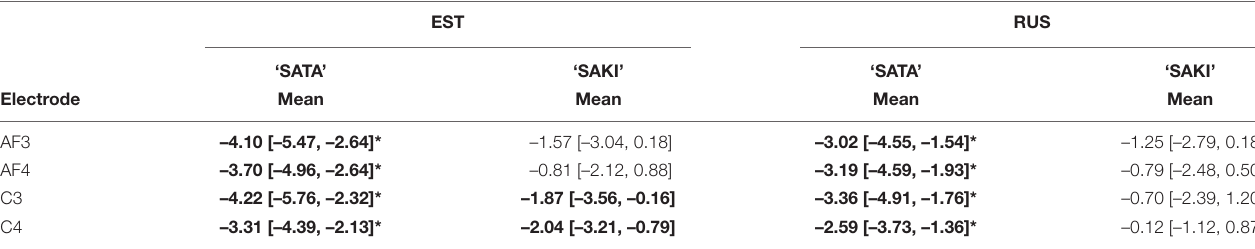
TABLE 6 | Results of bootstrap analysis for ‘Short ST-Long DEV’ vs. ‘Long ST-Short DEV’ conditions with 1000 resamplings for each Word set (‘SATA,’ ‘SAKI’), Language group (EST, RUS) and Electrode (AF3, AF4, C3, C4), models contained average activation of Duration comparisons × MMN. EST